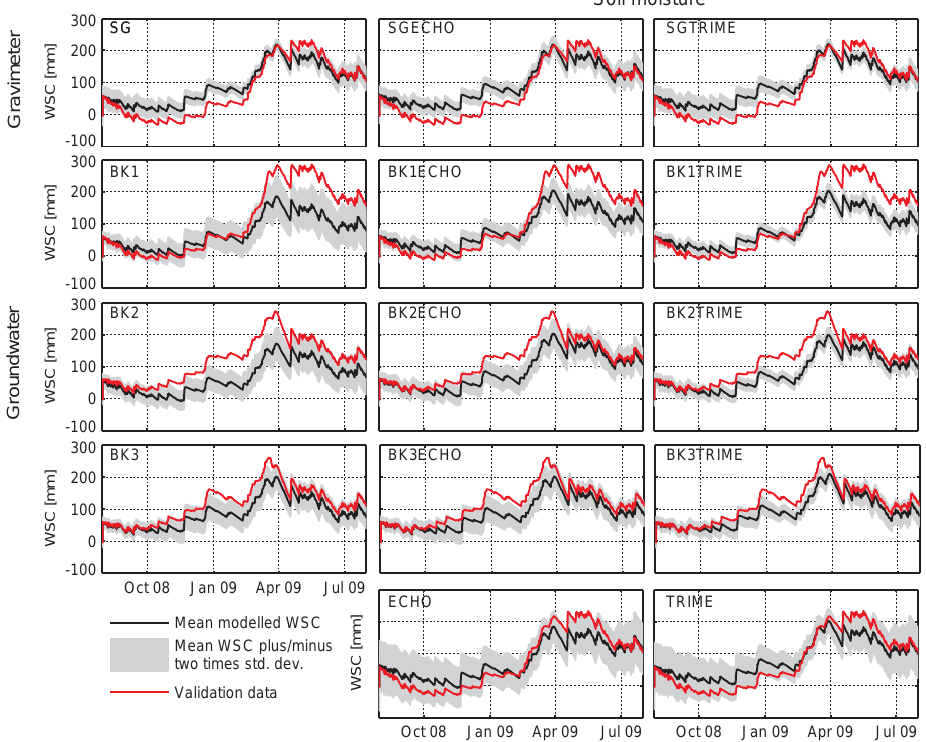
Fig. 6. Modelled WSC in comparison to the corresponding validation data estimated based on the lysimeter approach for the period of July 2008 to July 2009. The modelled WSC are presented as the mean of the behavioural model runs in combination with the mean plus/minus two times the standard deviations of the behavioural model runs (see Table 3 for explanation of different models).